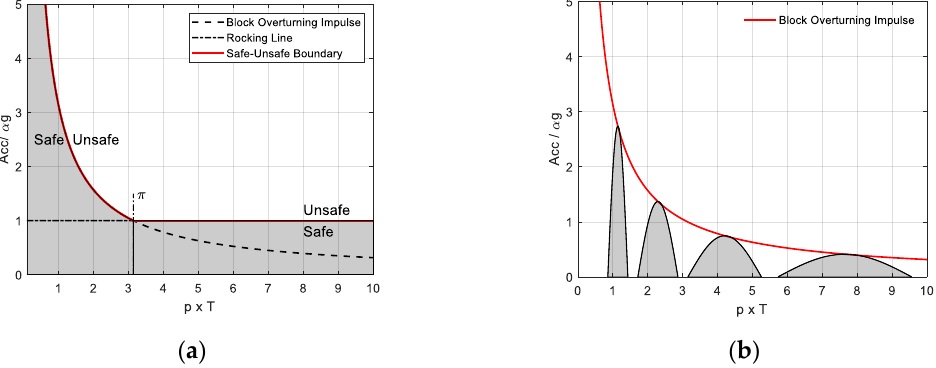
Figure 2. ( a ) Safe–unsafe boundary for half sine impulse signal and ( b ) shape of critical half-sine impulses.